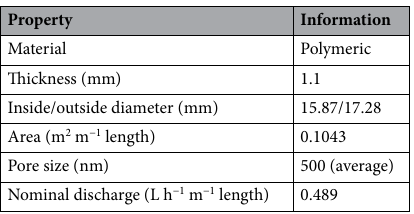
Table 1. 3rd generation Moistube membrane